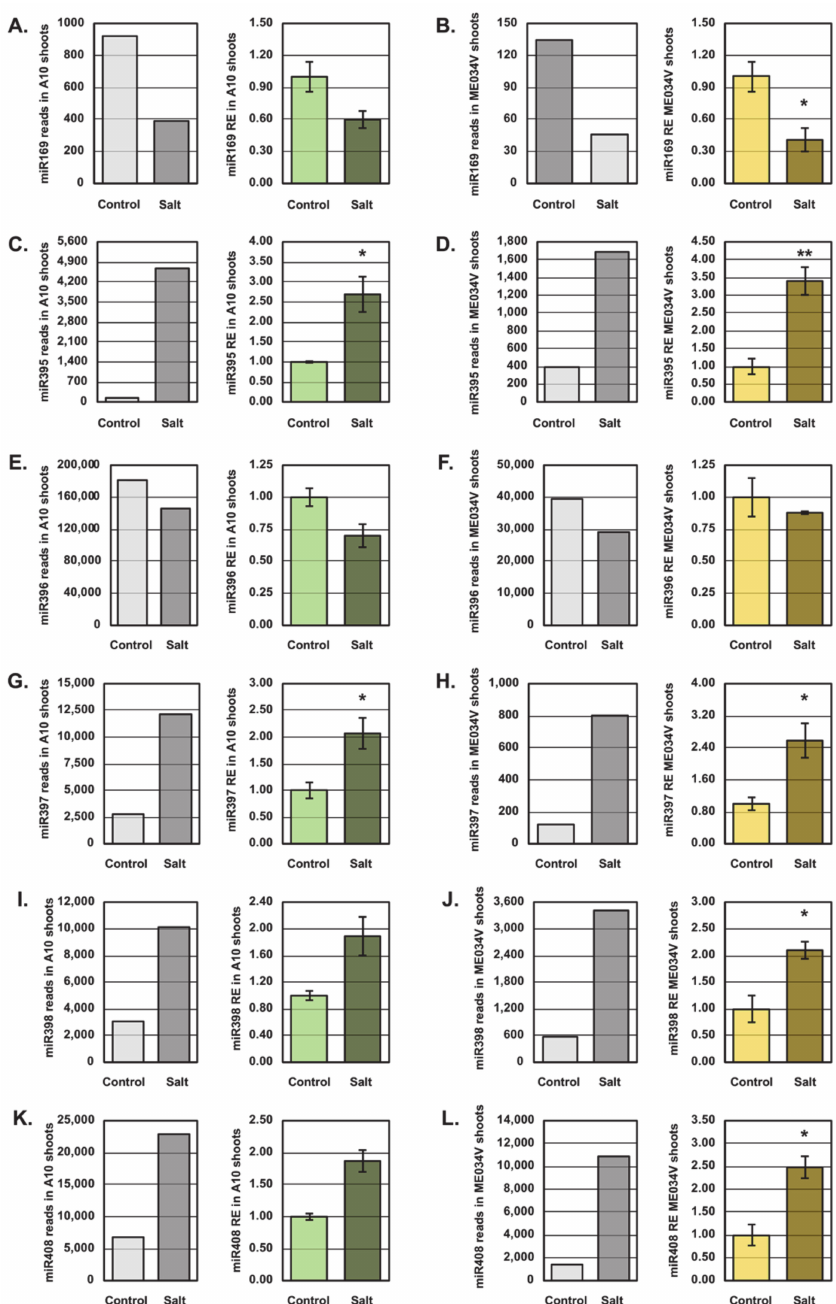
Figure 3. Experimental validation of the response of six miRNAs to salt stress in Setaria viridis shoots. RT-qPCR quantification of miRNA abundance to experimentally validate the sRNA sequencing identified abundance trends documented for the shoot tissue of 10-day-old salt stressed A10 and ME034V seedlings, including miR169 in salt stressed A10 ( A ) and ME034V ( B ) shoots, miR395 levels in A10 ( C ) and ME034V ( D ) salt stressed shoot tissues, miR396 abundance in salt stressed A10 ( E ) and ME034V ( F ) shoots, miR397 levels in salt stressed A10 ( G ) and ME034V ( H ) shoot material, miR398 abundance in salt stressed A10 ( I ) and ME034V ( J ) shoots, and the levels of the miR408 sRNA in salt stressed A10 ( K ) and ME034V ( L ) shoot samples. The bars on the histograms represent the standard deviation of the four biological replicates analyzed by RT-qPCR. Statistical di ff erence was determined with a t -test and the asterisks representing p -values of * p < 0.05 and ** p <